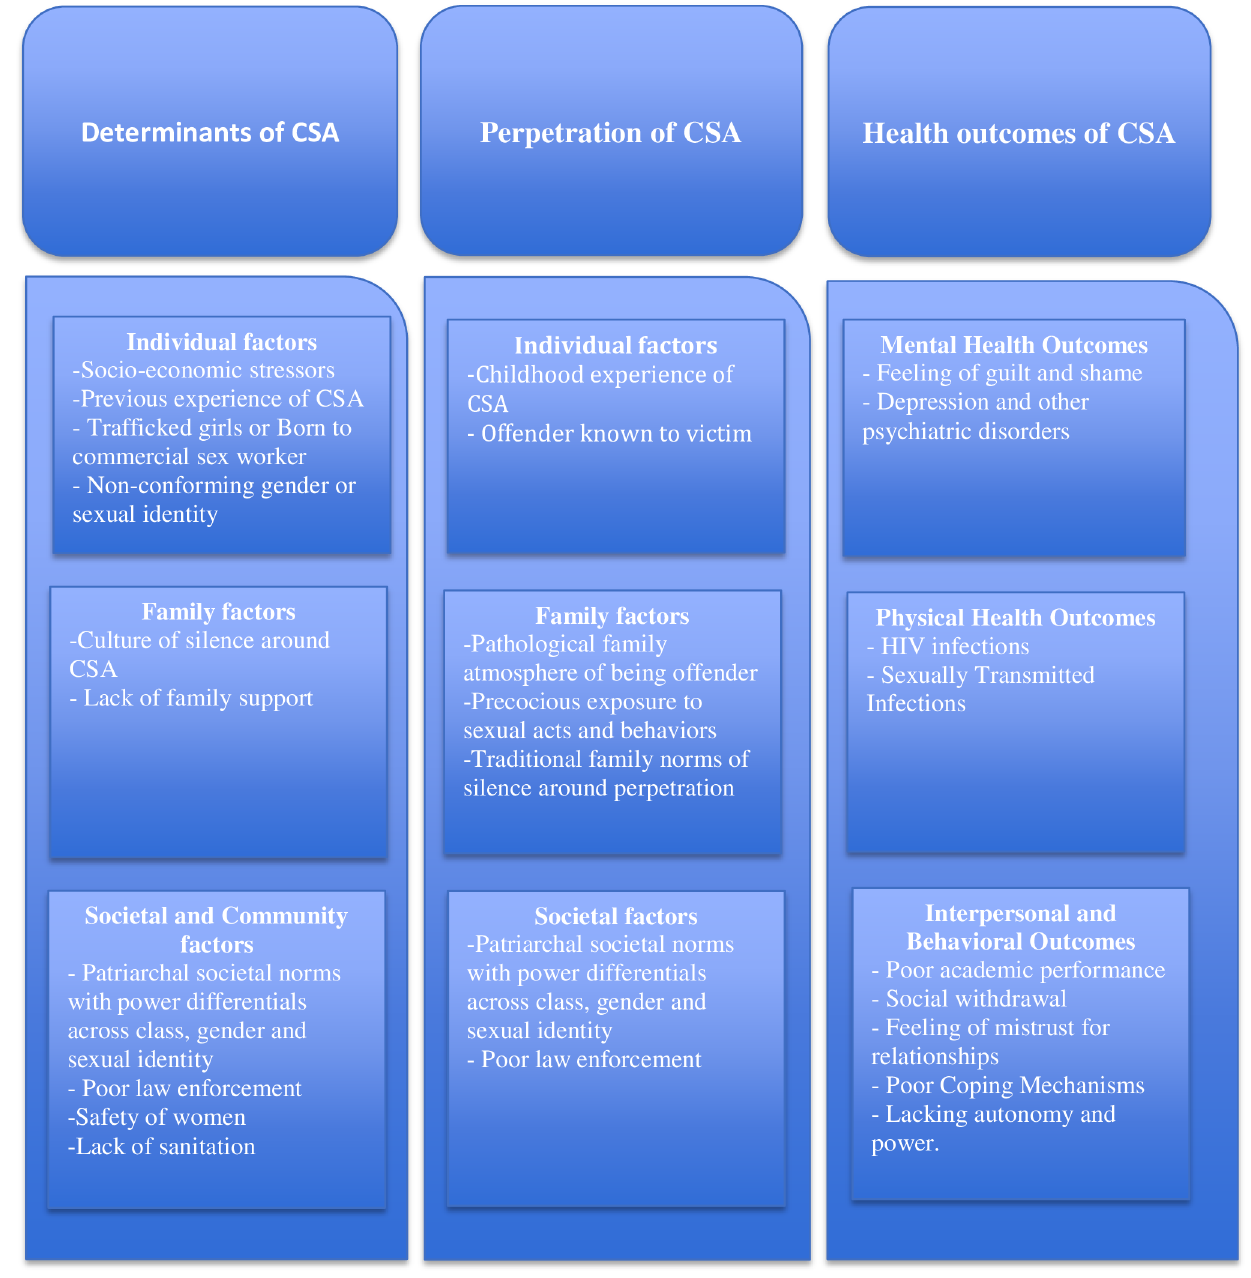
Fig 2. Synthesis of qualitative findings guided by social-ecological